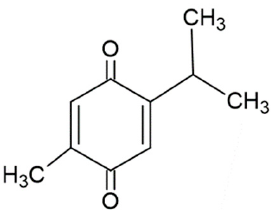
Figure 1. Chemical structure of thymoquinone (TQ).